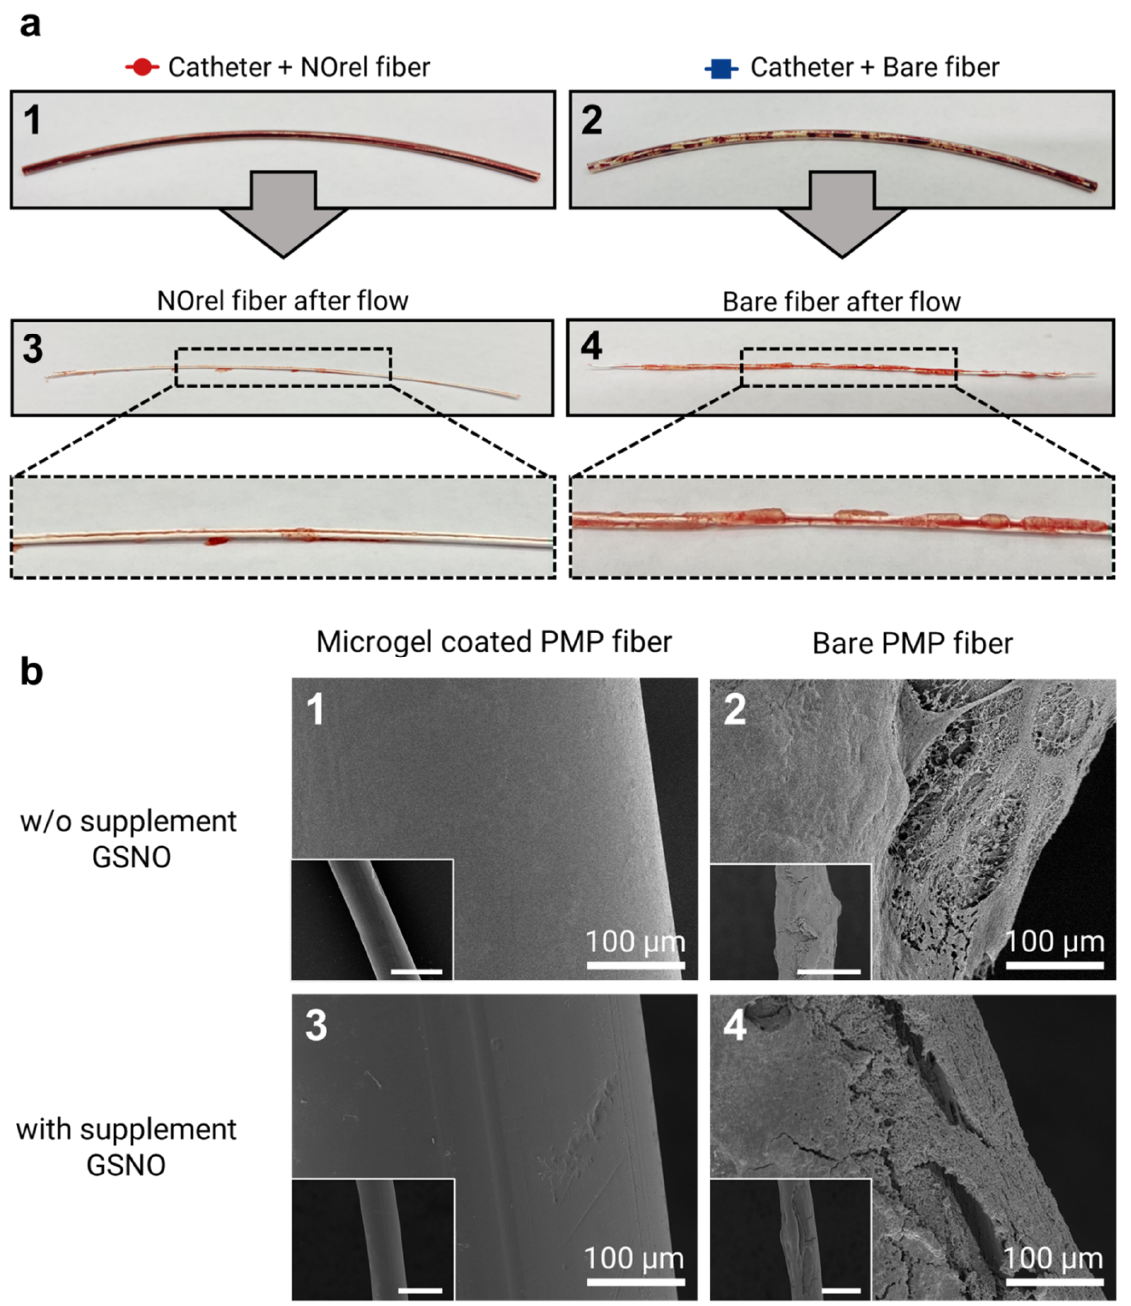
Figure 3. ( a ) Test channel after blood flow experiments for 48 min: the test channel contains (1) coated fibers with NOrel microgels and (2) control bare fibers. Uncoagulated blood can be seen within the test channel (1), while the blood clots are significantly found on the inner wall of the test channel (2). In the same way, the visual inspection of the extracted fibers from the corresponding test channel right after the blood flow experiment shows (3) no stable clot on the NOrel coated fiber, while (4) the significant layers of clot cover the surface of the uncoated fiber. ( b ) SEM analysis of the fibers used in the blood flow experiment: (1) the absence of any fibrin network on the surface of the NOrel coated fiber while (2) a dense layer of clot formed on the bare fiber after contacting the blood flow w/o infusion of supplementary S-nitrosoglutathione (GSNO). (3) A clot-free surface of the coated fiber was observed, while (4) low but still significant fibrin layers settled on the control fiber after exposure to the blood flow with supplementary GSNO. The insets indicate the wide field of view, respectively. Scale bar: 500 µ